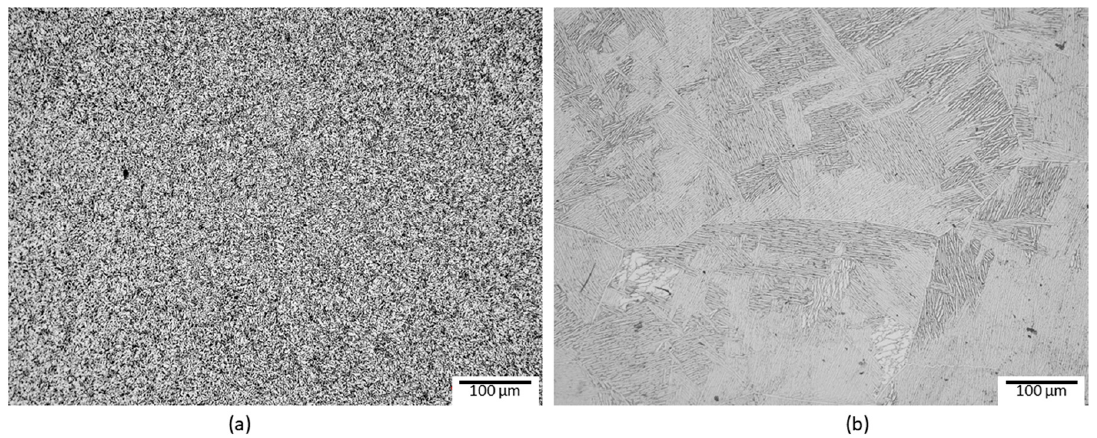
Figure 1. The Ti-6Al-4V alloy in the as-received annealed condition with equiaxial microstructure ( a ) and after heat treatment to obtain the Widmanstätten-type microstructure ( b ).